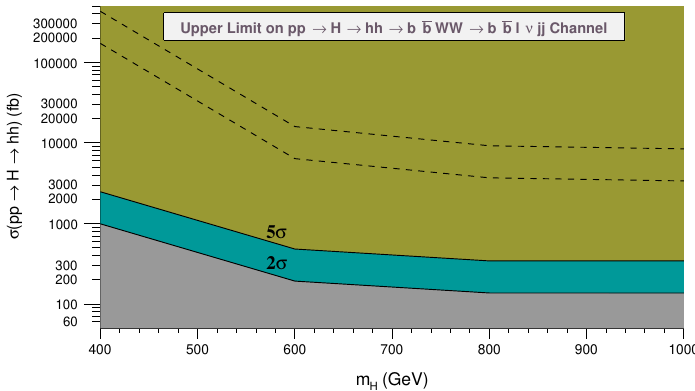
Figure 22 . Upper limit on (cid:27) ( pp channel. The solid (dashed) lines show the 2 (cid:27) -5 (cid:27) band on taking 0% (5%) systematic uncertainties.